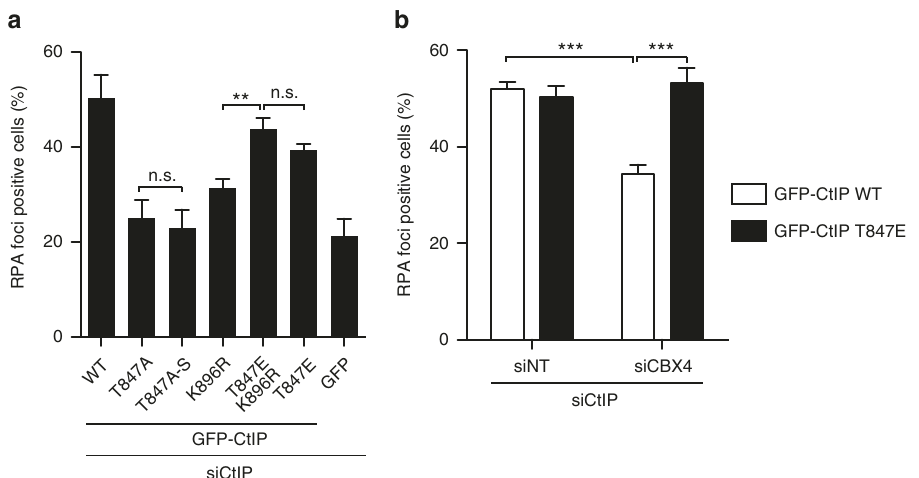
Fig. 5 Phosphorylation of CtIP at T847 overcomes a lack of CBX4-mediated sumoylation for DNA resection. a RPA foci were measured 1 h after 10 Gy ionizing radiation in U2OS cells depleted of endogenous CtIP but expressing the indicated GFP-CtIP versions or GFP as a control. Statistically signi fi cance was determined with one-way ANOVA analysis, and only biological relevant comparisons are shown. b Same as a except that cells were co-transfected with a mix of siCtIP and siCBX4, or siNT as a control, as indicated. Values of RPA foci-positive cells were normalized to the percentage of S/G2 cells (Supplementary Fig. 8e), as in Figs. 1b and 3f. Statistically signi fi cance of differences was analyzed with two-way ANOVA. The average and SEM of three independent experiments were plotted in both panels. * P < 0.5; ** P < 0.05; *** P <